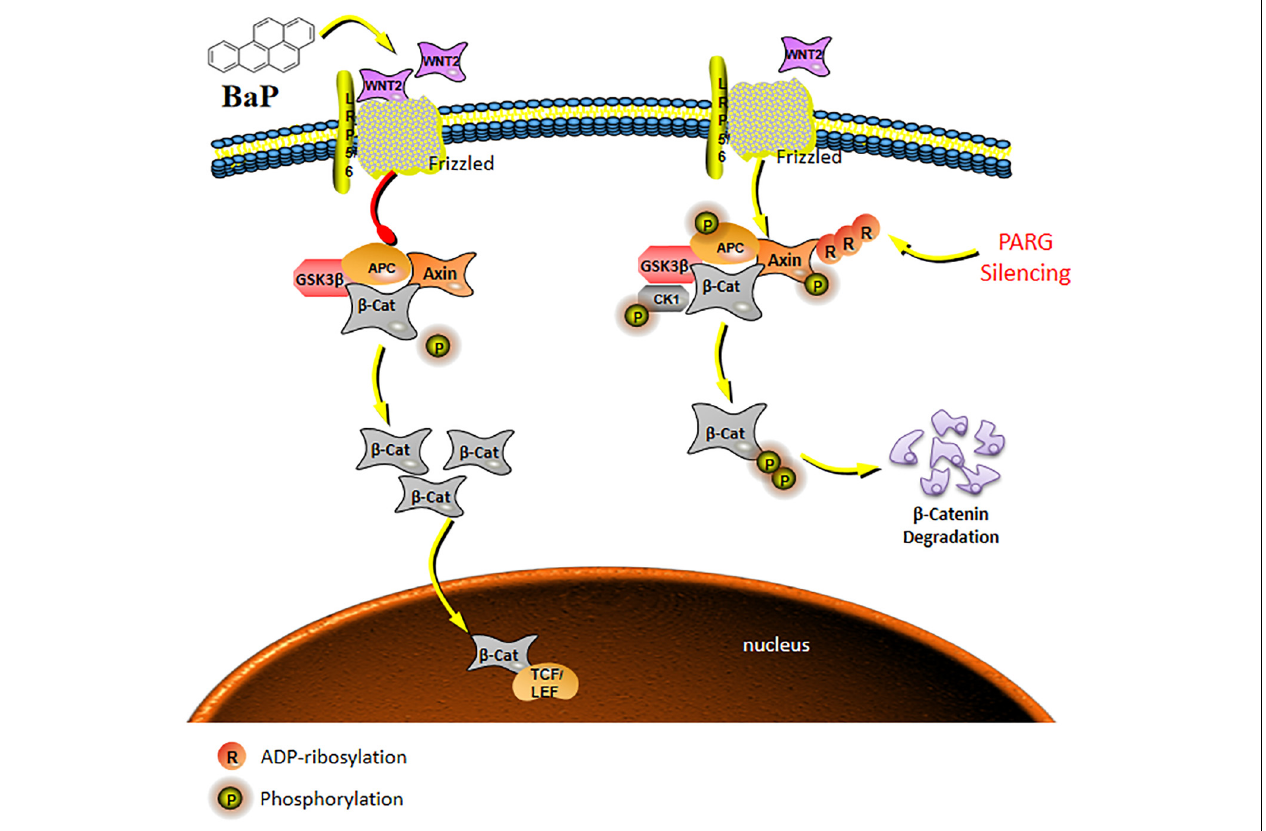
FIGURE 6 | Schematic model of the Wnt/ β -catenin signaling pathway regulated by PARG gene silencing during BaP-induced lung cancer. After activation of the canonical pathway, Wnt ligands bind to Frzzled and LRP5/6 on the cell surface to form a trimer, which weakens the stability of a destruction complex composed by β -catenin, Axin, GSK-3 β , and APC to prevent the phosphorylated degradation of β -catenin. The concentration of β -catenin increases in the cytoplasm, and then transfers into the nucleus to ultimately activate the expression of downstream target genes. PARG gene silencing may promote binding of phosphorylated proteins to the Axin scaffolding proteins, affecting the stability of the key protein β -catenin, and then suppressing the activation of the Wnt/ β -catenin pathway to stabilize the expression of Wnt2b against the progression of lung